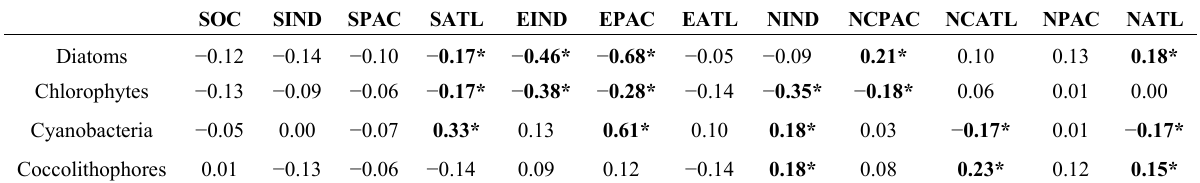
Table 2. Correlation coefficients between group-specific primary production and the Multivariate El Niño Index (MEI) in 12 major oceanographic basins. Bold and (*) indicates statistical significance ( p < 0.05). See Table 1 for a list of